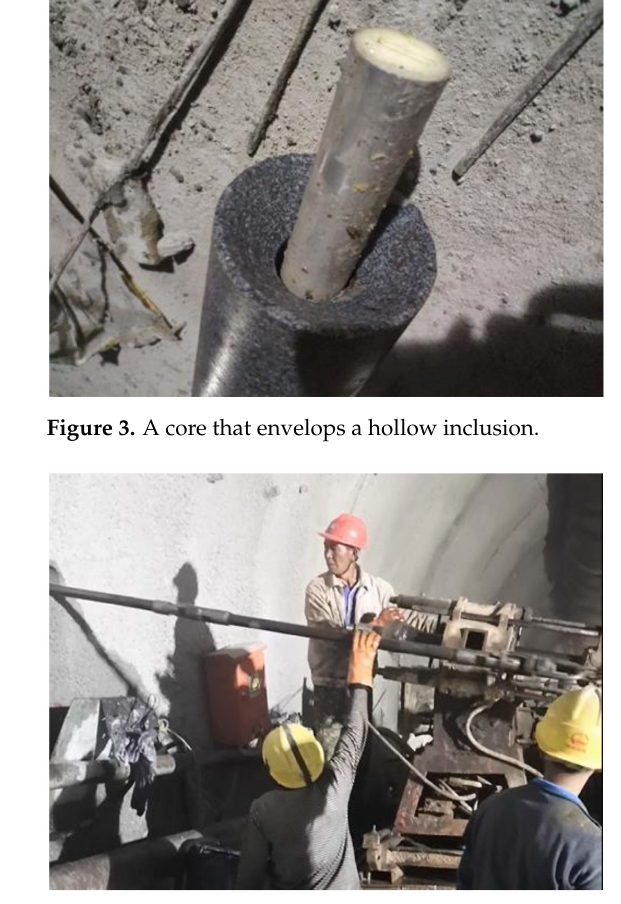
Figure 4. Drilling operation in the field.